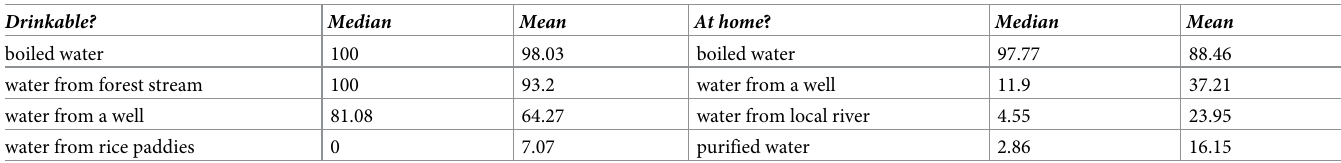
Table 6. Sources of water acceptable to drink and sources used at home. Drinkable? Median Mean At home ? Median Mean boiled water 100 98.03 boiled water water from forest stream 100 93.2 water from a well 81.08 64.27 water from rice